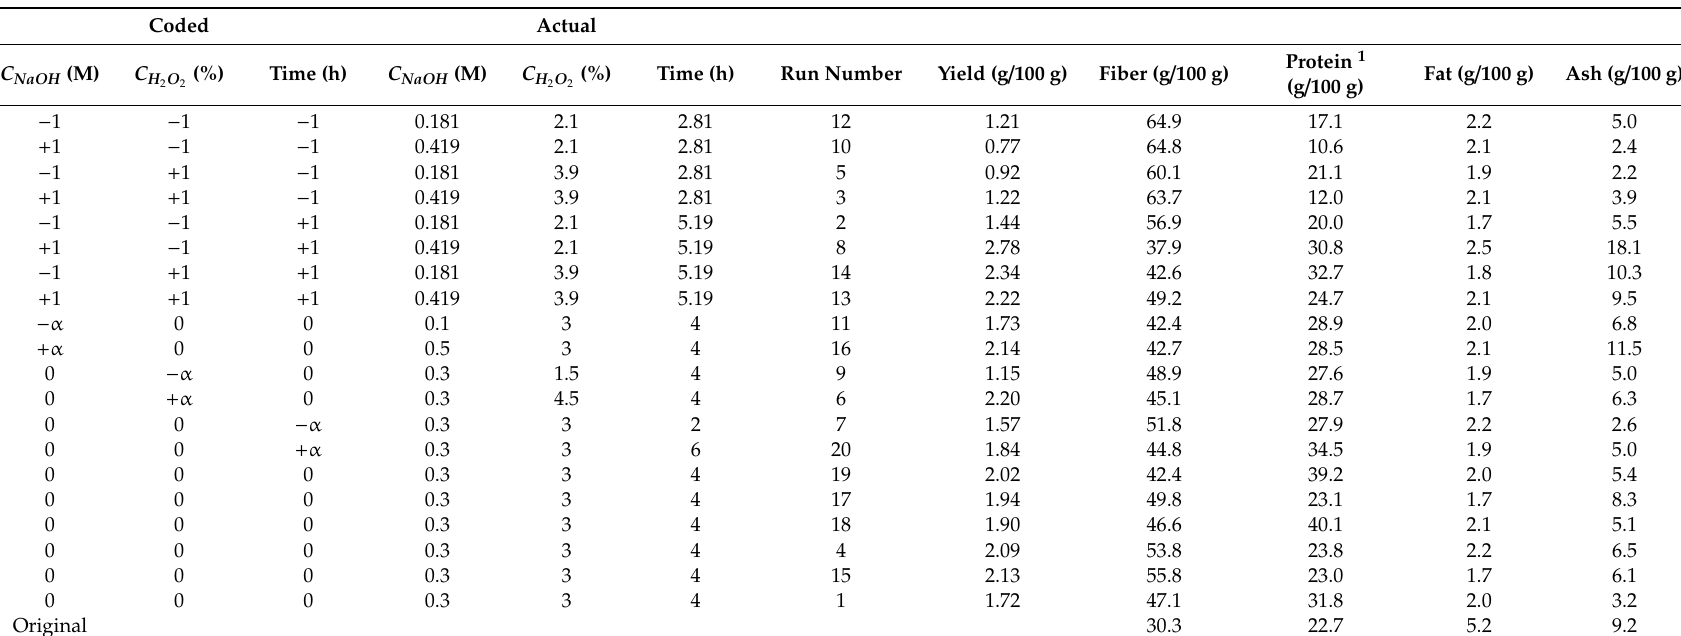
Table 1. Coded and actual variables for the experimental design for the optimization of mushroom dietary fiber isolation, yield (in relation to the initial mushroom fresh weight) and chemical composition concerning the fiber, protein, fat and ash of the dietary fiber ingredient (DFI) obtained in each